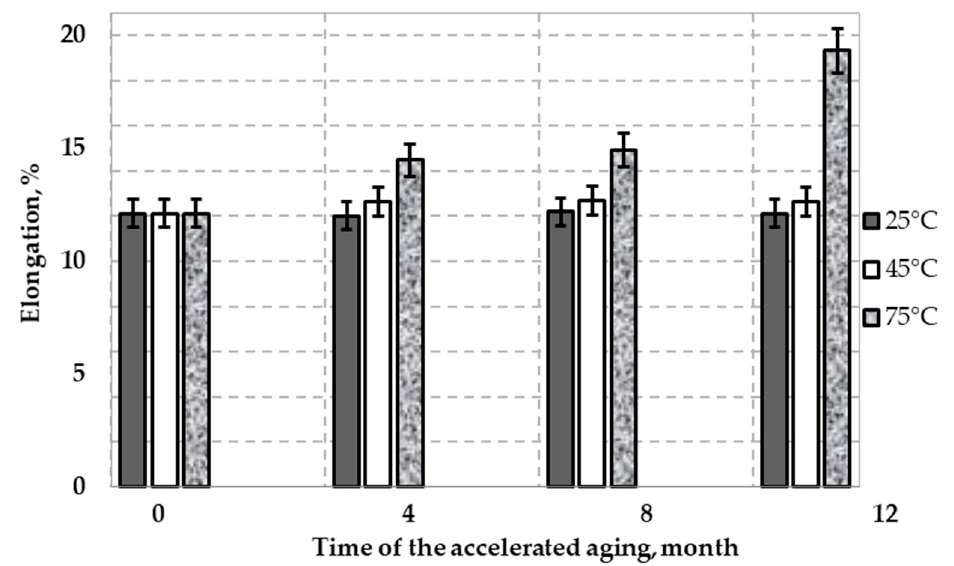
Figure 9. Variation of relative elongation ( ε ) HDPE geogrid sample with time in leachate at three temperatures: 25 °C, 45 °C, and 75 °C.